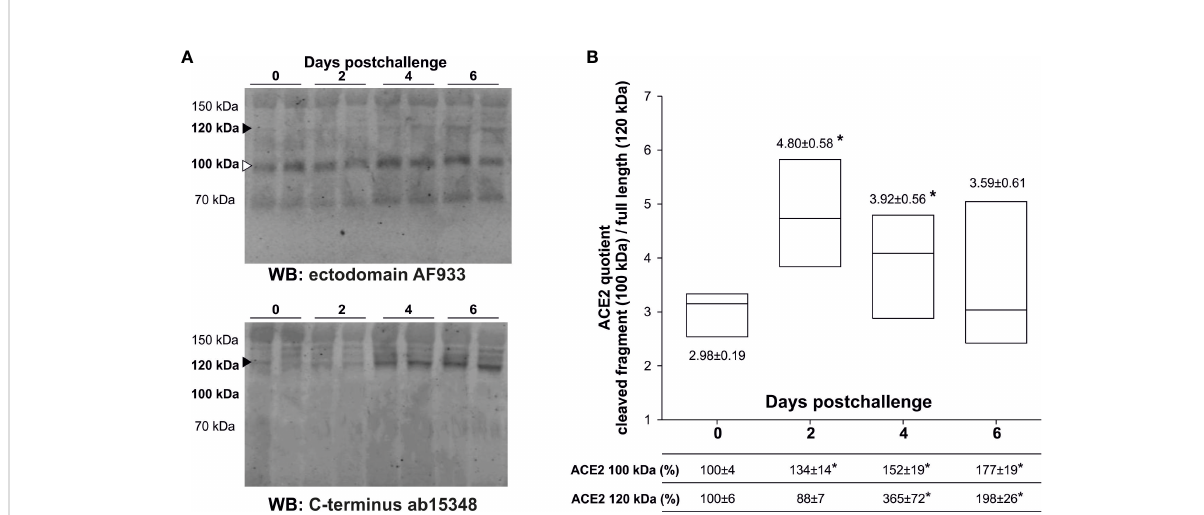
FIGURE 1 Levels of serum ACE2 species from challenged K18-hACE2 mice. Transgenic K18-hACE2 mice (n= 11), expressing human ACE2, were challenged with a lethal dose of SARS-CoV-2 (MAD6 strain) by the intranasal route. Serum ACE2 species were analyzed in non-infected mice (day 0; n= 9), and at days 2 (n= 3), 4 (n= 3) and 6 (n= 5) postchallenge. (A) Representative western blots with two different cases for each condition are showed; resolved with the ectodomain AF933 and the C-terminus ab15348 antibodies to de fi ne cleaved fragments (white arrow- head) and full-length (black arrow-head) species. The cleaved 100 kDa ACE2 species after shedding are recognized by the AF933, but not by the C-terminal ab15348 antibody. (B) The densitometric quanti fi cation of the full-length 120 kDa ACE2 species (black arrow-head) and its presumable cleaved 100 kDa fragment (white arrow-head) were estimated from the immunoreactivity obtained with the AF933 antibody, and as the percentage respect to day 0 levels. The densitometric quanti fi cation of the 120 kDa ACE2 species obtained with the ab15348 is presented in the main text. All samples were analyzed at least in duplicate in separate blots. Box plots represent the quotient obtained by dividing the level of immunoreactivity of the 100 kDa fragment by the level of immunoreactivity of the 120 kDa full-length form. The bars within the box plot represent the median abundance for the given group. (*) signi fi cant p values ( p < 0.05) respect to day